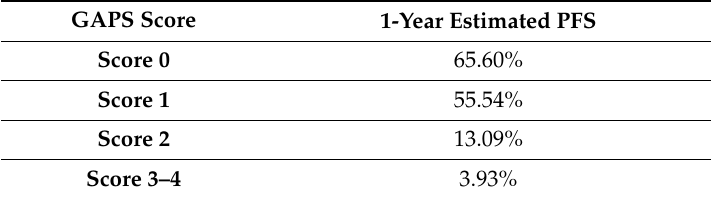
Table 4. One-year estimated PFS according to GAPS